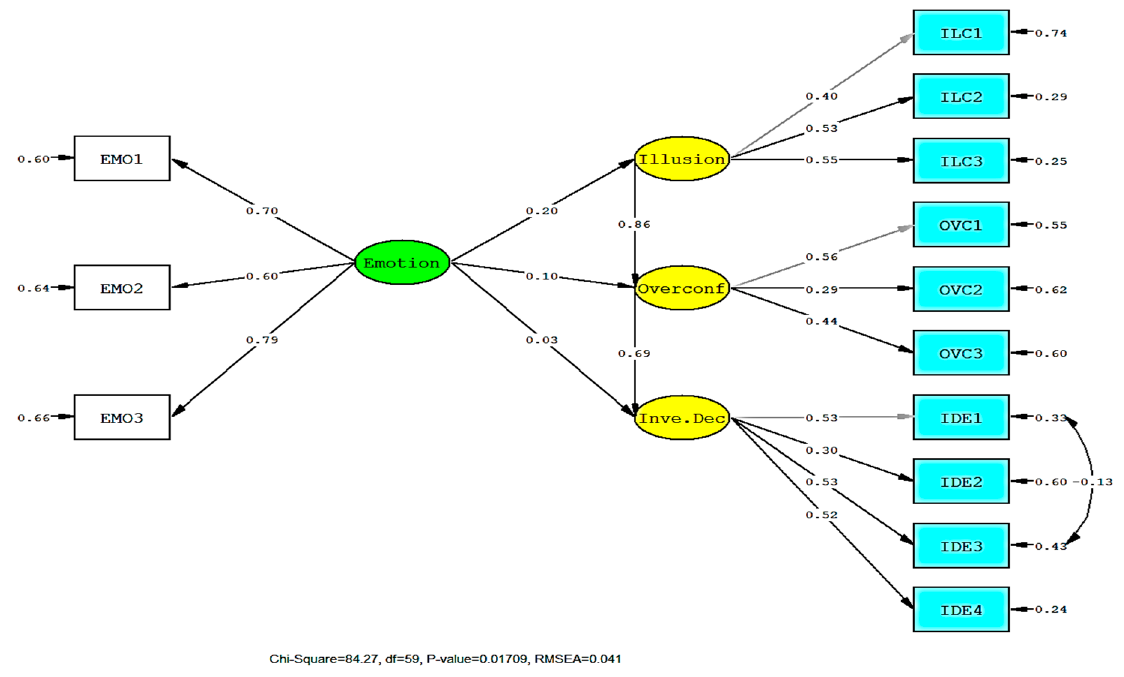
Figure 1. The Path Model (Source: Lisrel output).